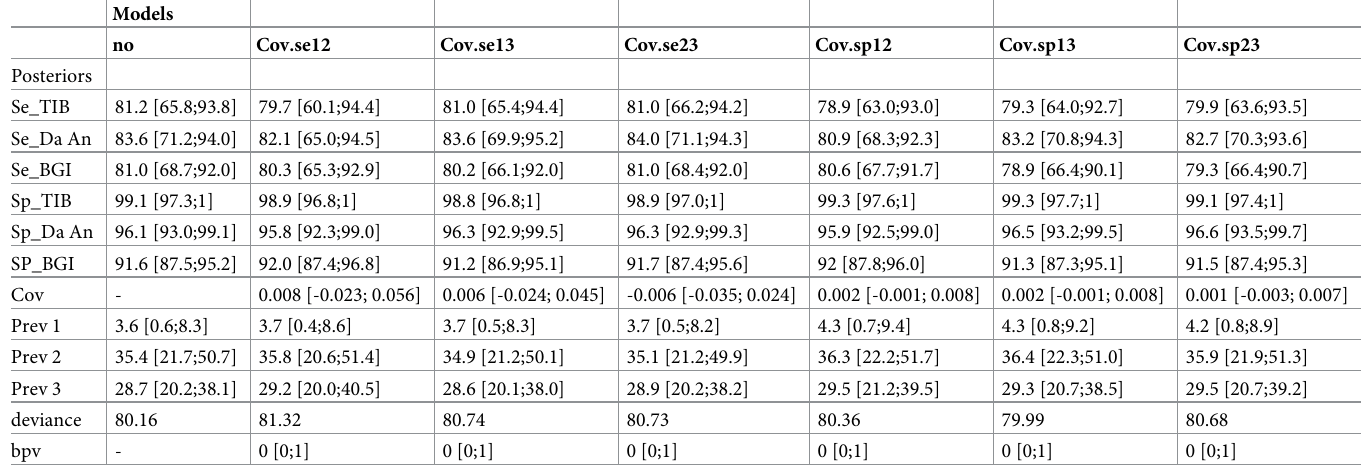
Table 6. Posteriors means and corresponding 95% credible intervals (CrI) of BLCM models with different pair wise covariance’s added, Addis Ababa, Ethiopia,2021. Models